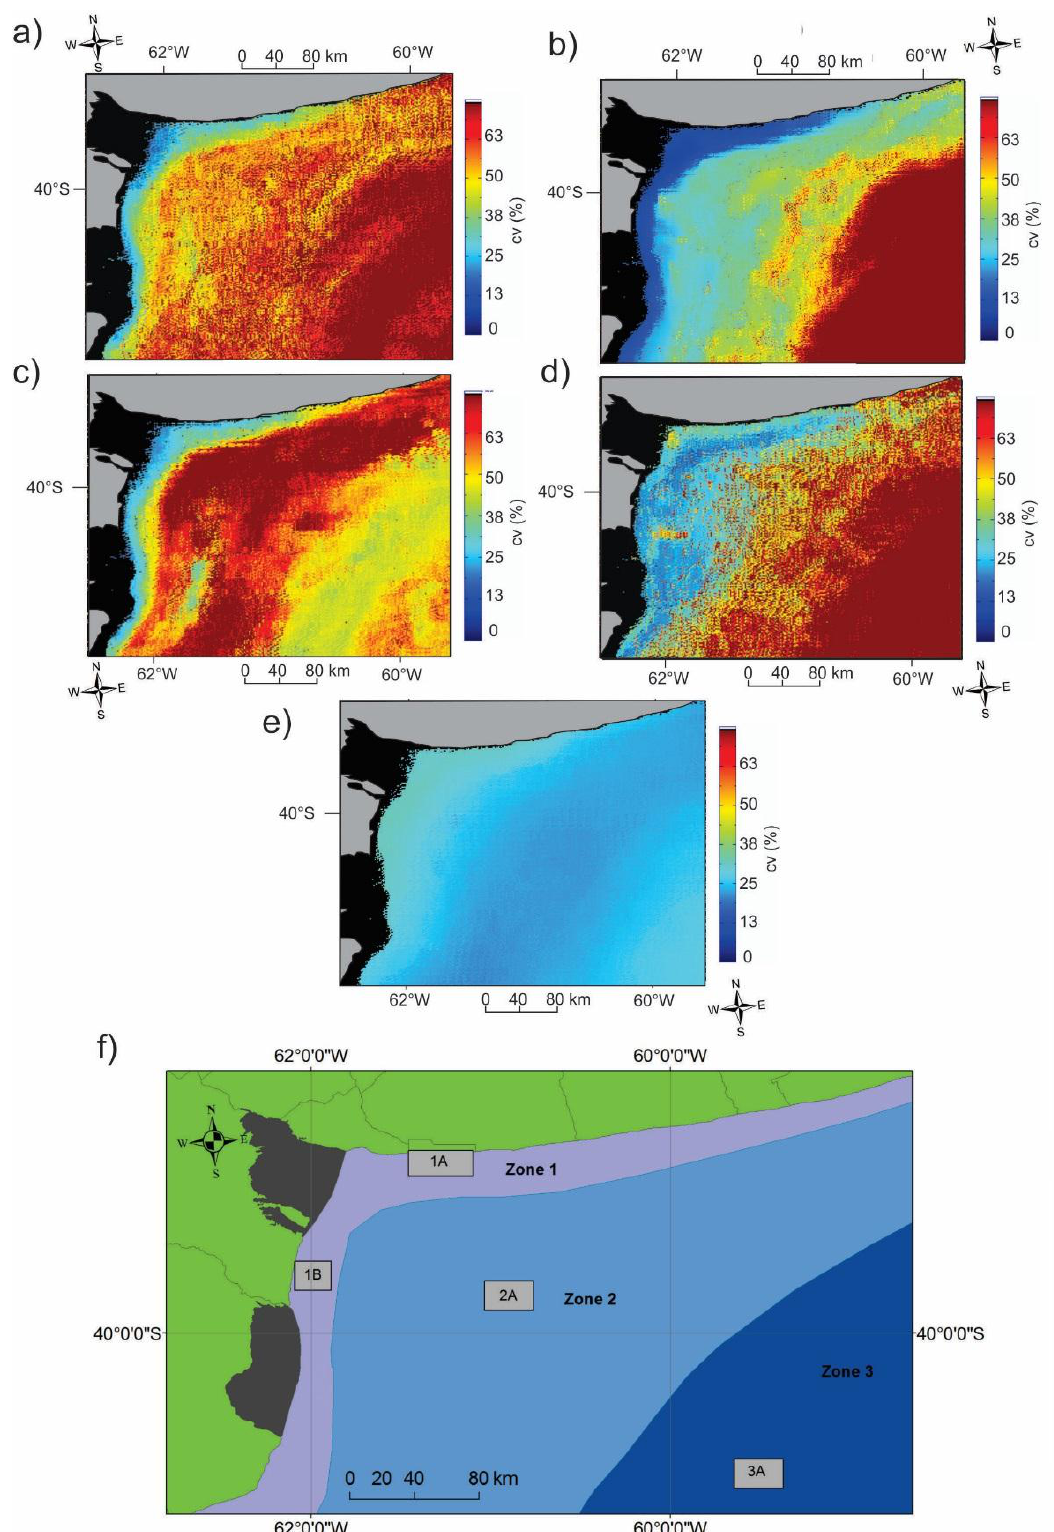
Figure 3. Variability coefficient of the parameters in the study area. ( a ) a ph (443); ( b ) chl- a ; ( c ) b bp (443); ( d ) a dg (443); ( e ) SST ; and ( f ) regionalization map and selected ‘regions of interest’ for temporal